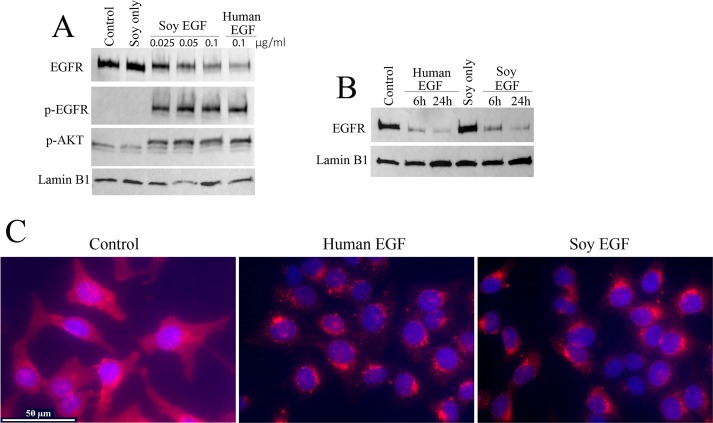
Soybean produced EGF displayed comparable bioactivity to commercially available EGF.Panel A. Soybean produced hEGF induces a rapid phosphorylation of Hela cell EGFR. Serum free media (SF) and SF media with soymilk alone does not induce EGFR phosphorylation and degradation. Soymilk from seeds producing ShEGF added at different concentrations (0.1, 0.05, 0.025 μg/ml) induced concentration-dependent EGFR degradation comparable to the effect of rhEGF. Serum free media and serum free media with nontransgenic soybean soymilk (negative controls) showed no effect on inducing pEGFR. In contrast soymilk from ShEGF soybeans given at different concentrations (0.1, 0.05, 0.025 μg/ml) induced pEGFR comparable to control rhEGF. pAKT indicates the functional activation of EGFR. Lamin B1 was used as a loading control. Panel B. Exogenous commercial rhEGF and ShEGF induces an internalization and degradation of EGFR in Hela cells shown as a decrease in abundance assayed by immunoblot. The results shown demonstrate that soymilk alone has no intrinsic bioactivity with respect to EGFR abundance. The rhEGF is not degraded in soymilk over 24 hours having the same bioactivity as control recombinant rhEGF.—Ctrl- SF media alone. Soy EGF and rhEGF are at 0.1 μg/ml. Lamin B1 was used as a loading control. Panel C. Shown is an immunohistochemical assay of Hela cells showing that ShEGF induces internalization of the EGFR comparable to that from control rhEGF. In C, the cells were first treated with soy/EGF or human EGF for 6 hours, fixed and then immunostained with EGFR antibody overnight. EGFR shows red staining while nucleus was stained by DAPI and shows blue staining.